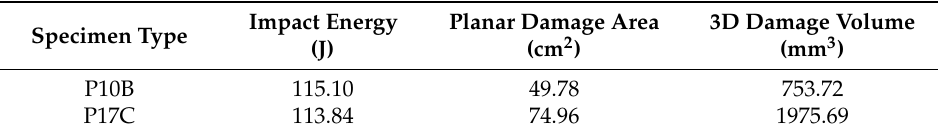
Table 5. Ballistic performance of the non-perforated